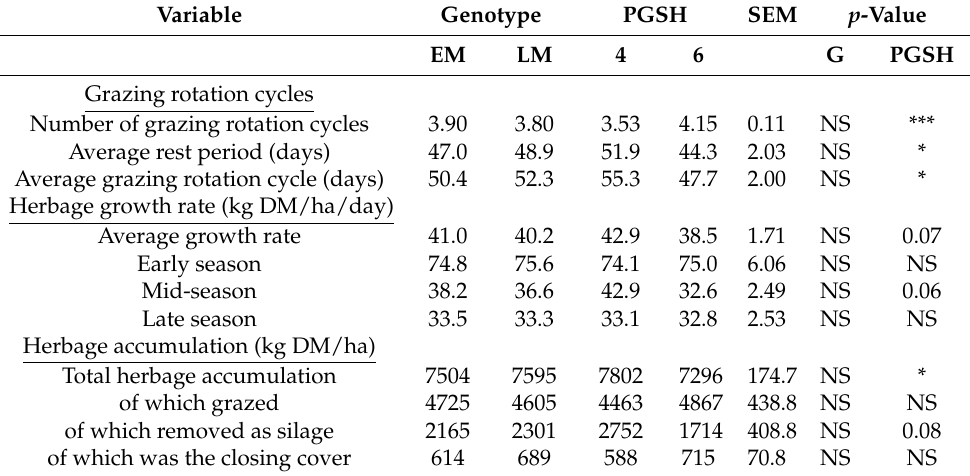
Table 7. Effect of genotype (G-early- (EM) or late-maturing (LM)) and post-grazing sward height (PGSH-4 or 6 cm) on grazing rotation cycle, herbage growth rate and herbage accumulation.